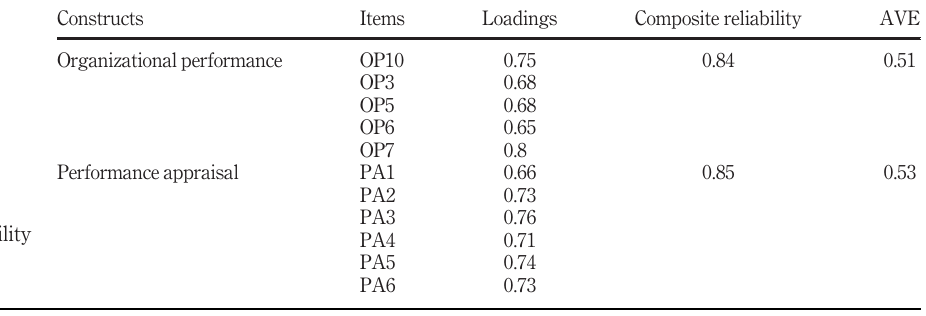
Table II. Discriminant validity (Fornell – Lacker